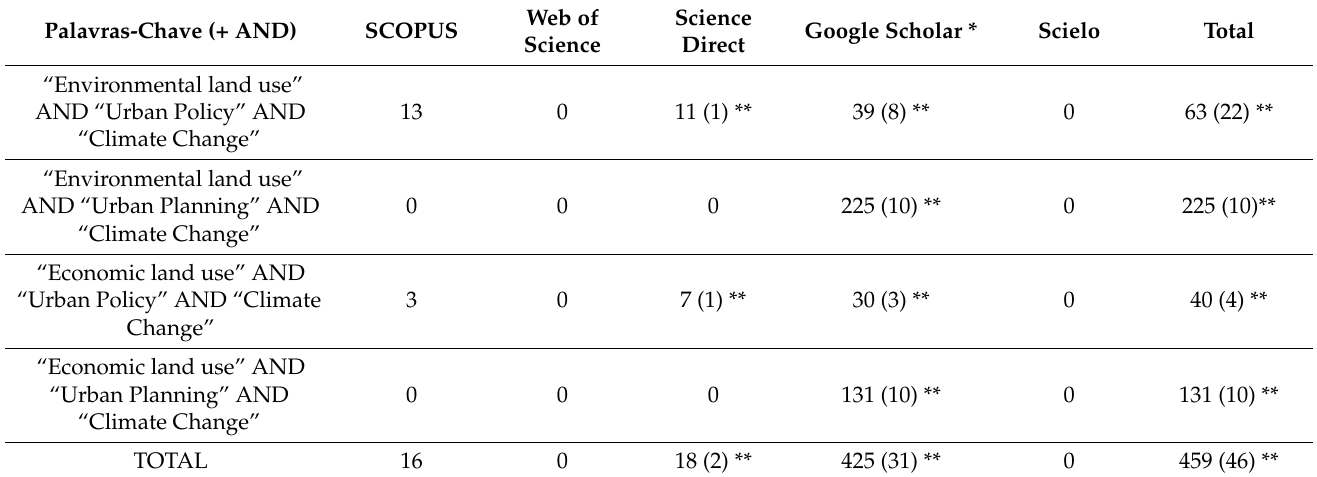
Table 1. Description of results by database/indexers.